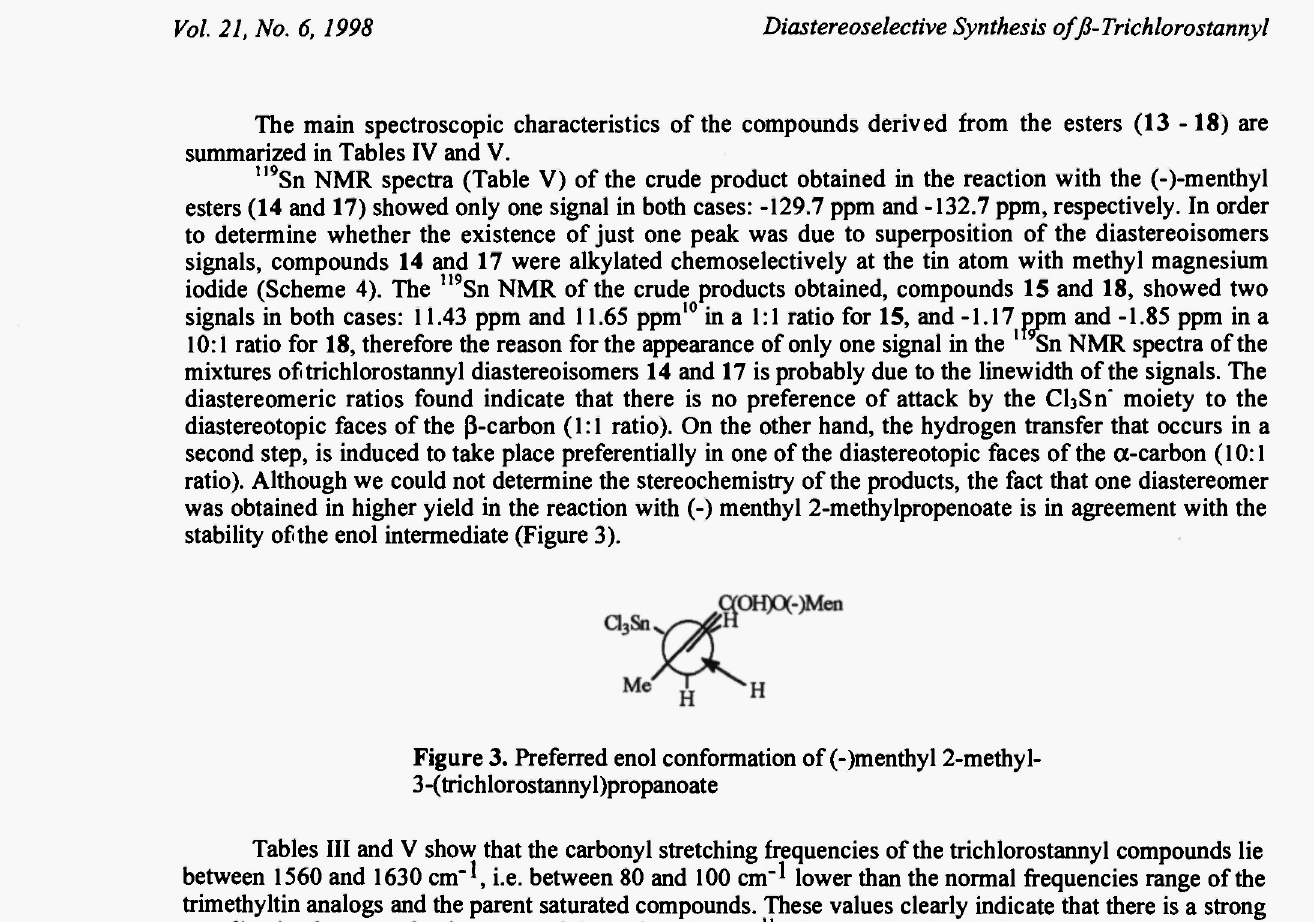
Table IV. ·η NMR data of compounds 13-18"